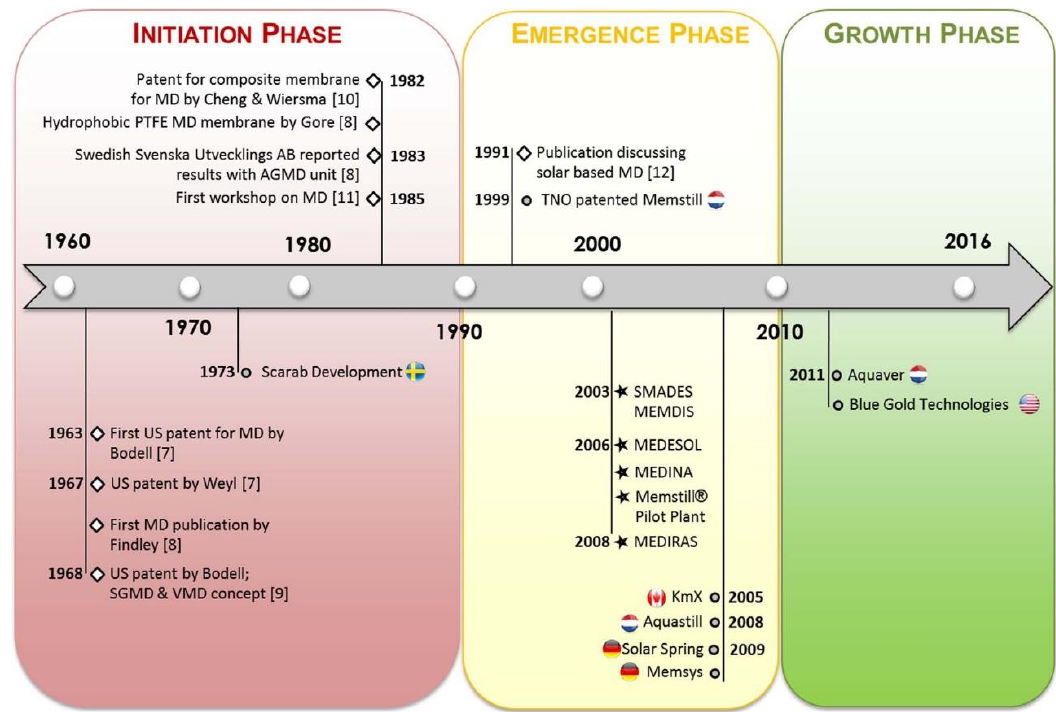
Figure 1. Timeline for membrane distillation (MD) development (diamond symbol indicates the milestone events; star symbol indicates the MD projects/pilot plant; gray circular symbol indicates the launch of technology developer companies with the location of their headquarters). Reproduced with permission from [8]. Copyright Elsevier, 2017.